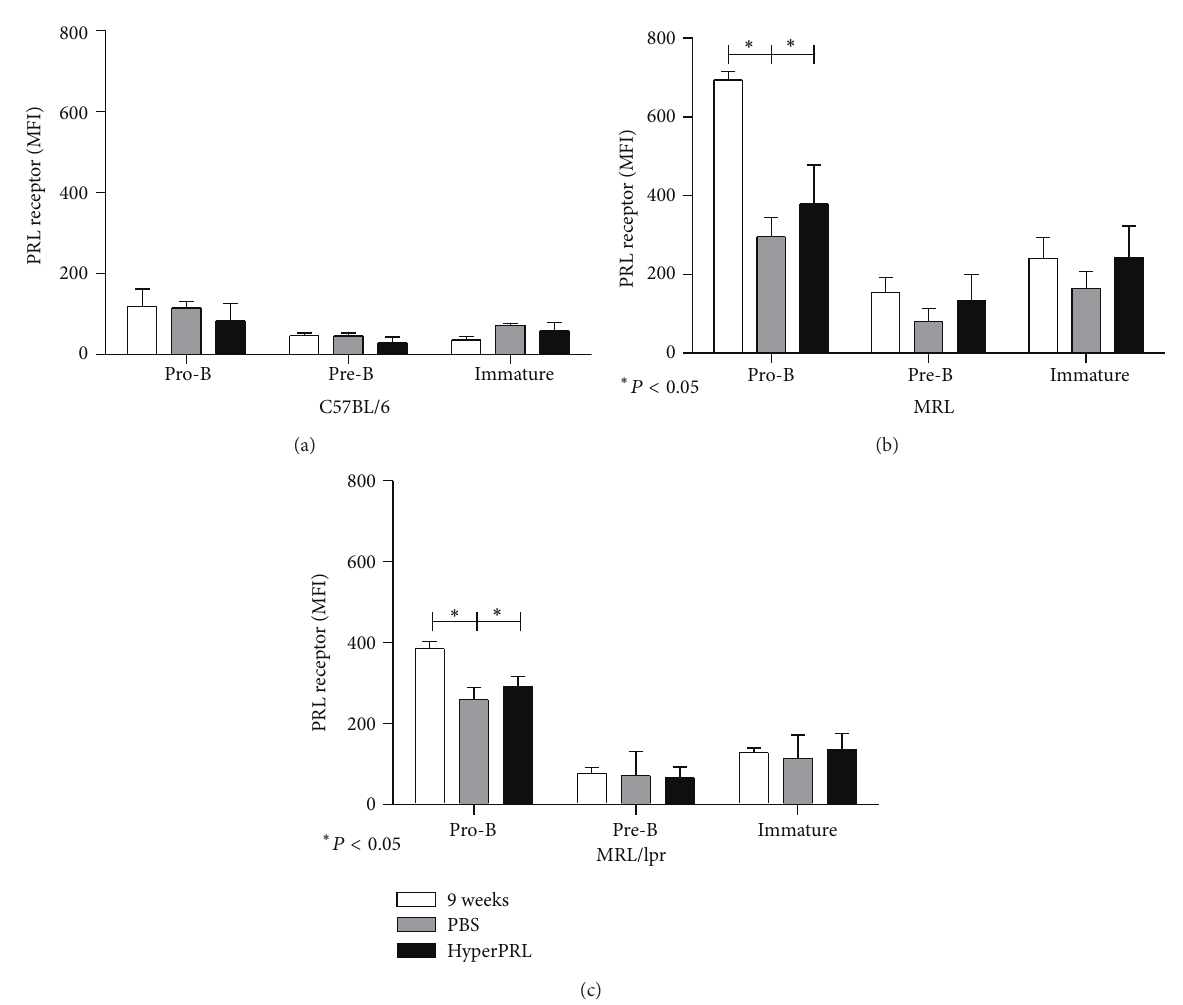
Figure 3: Prolactin receptor expression after the induction of hyperprolactinemia. The levels of PRL receptor protein (MFI) in the B cells from BM (pro-B, preB, and immature) were measured using flow cytometry. At the end of the treatment, the BM cells were labelled with anti-B220, anti-CD43, anti-CD23, anti-IgM, and goat anti-PRL receptor antibodies. (a) C57BL/6 mice; (b) MRL mice; (c) MRL/lpr mice. The asterisks denote statistical significance between populations with the P value shown. The MFI values expressed in the graphs correspond to the MFI values minus the isotype